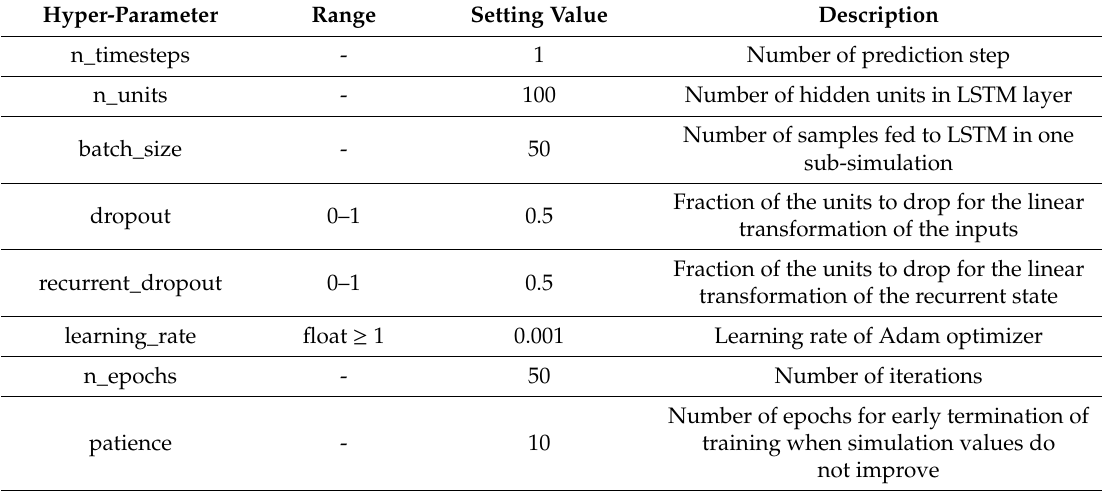
Table 3. Setting values of hyper-parameters in